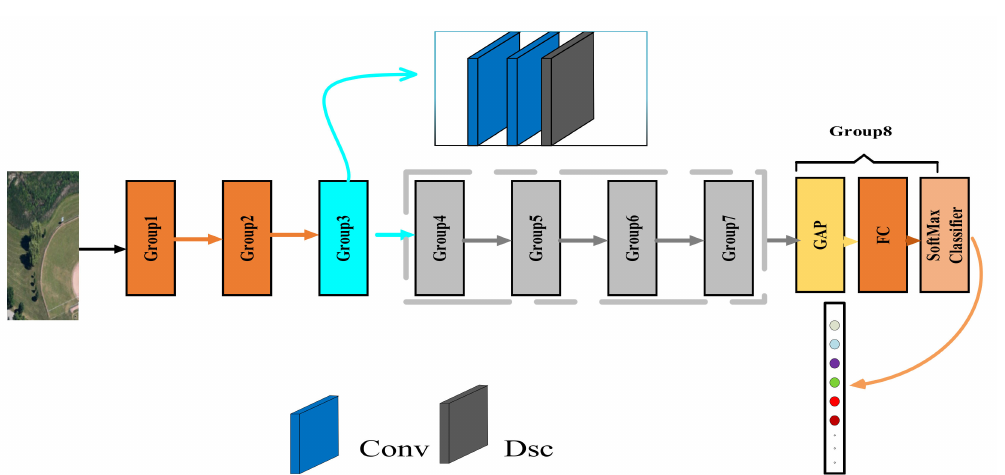
Figure 1. The proposed LCNN-CMGF network structure. Groups 1 and 2 are shallow downsampling modules. Group 3 is hybrid convolution. Groups 4–7 are channel multi-group fusion modules. Group 8 is the global average pooling, fc and